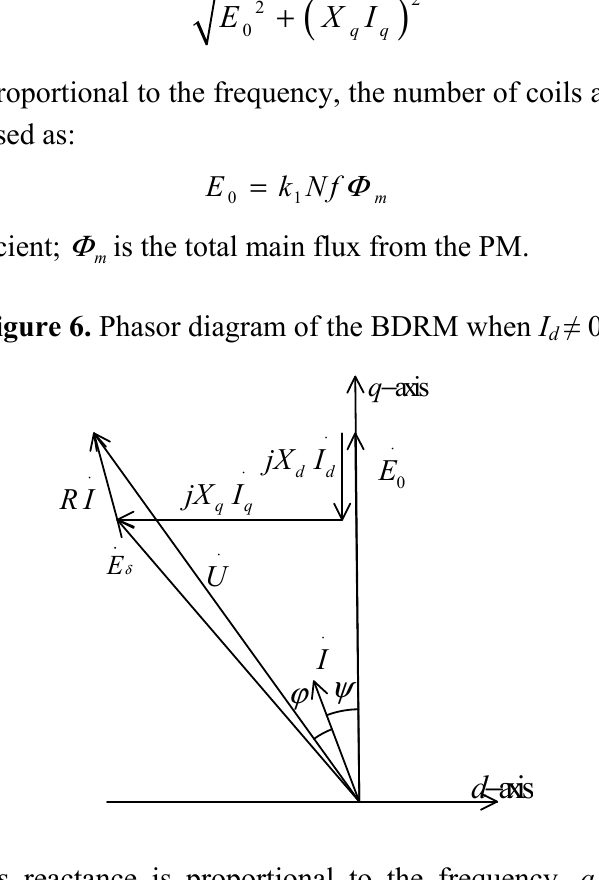
Figure 6. Phasor diagram of the BDRM when I